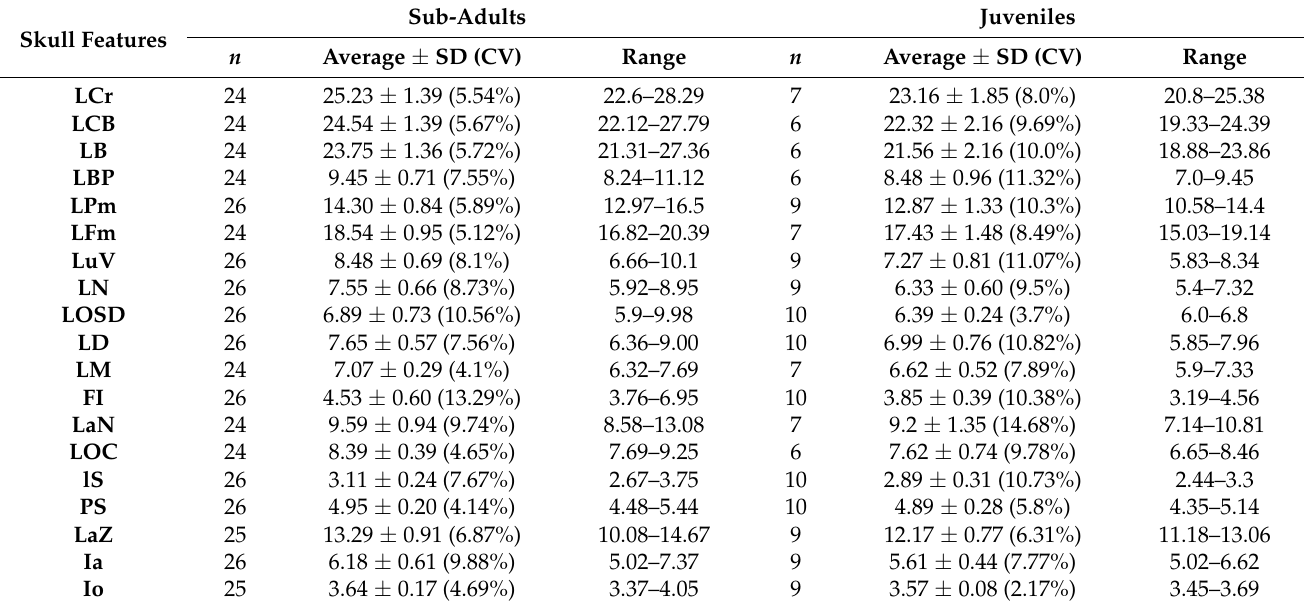
Table 6. Cranial signs in sub-adult and juvenile Pannonian root